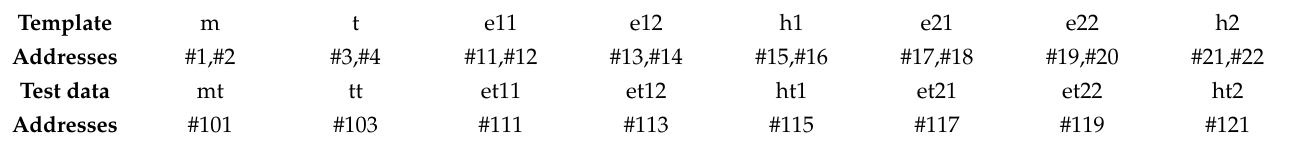
Table 6. Structure of template and input test data to be written in SRAM for entry